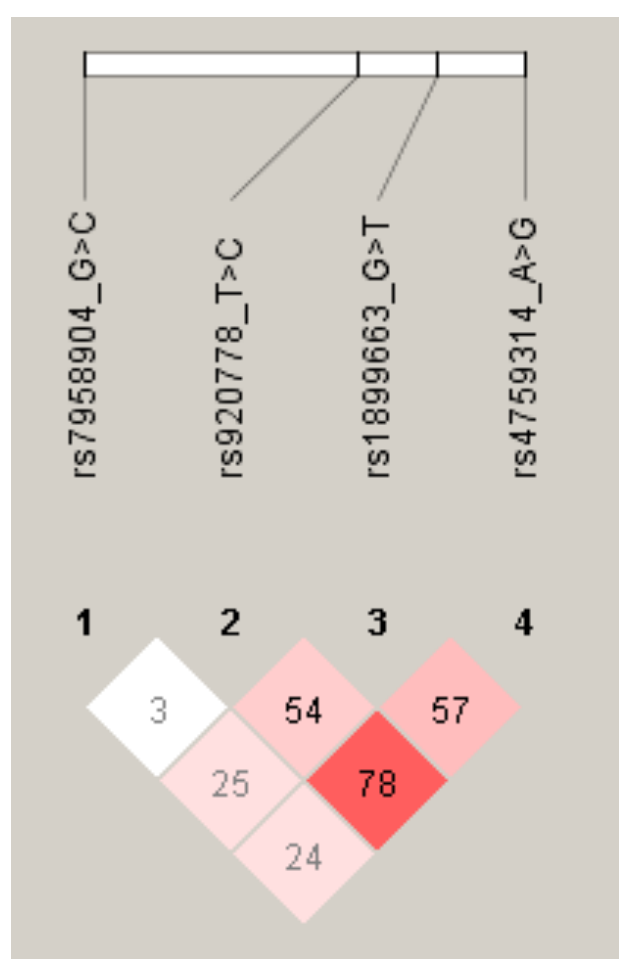
Figure 1. Linkage disequilibrium between HOTAIR